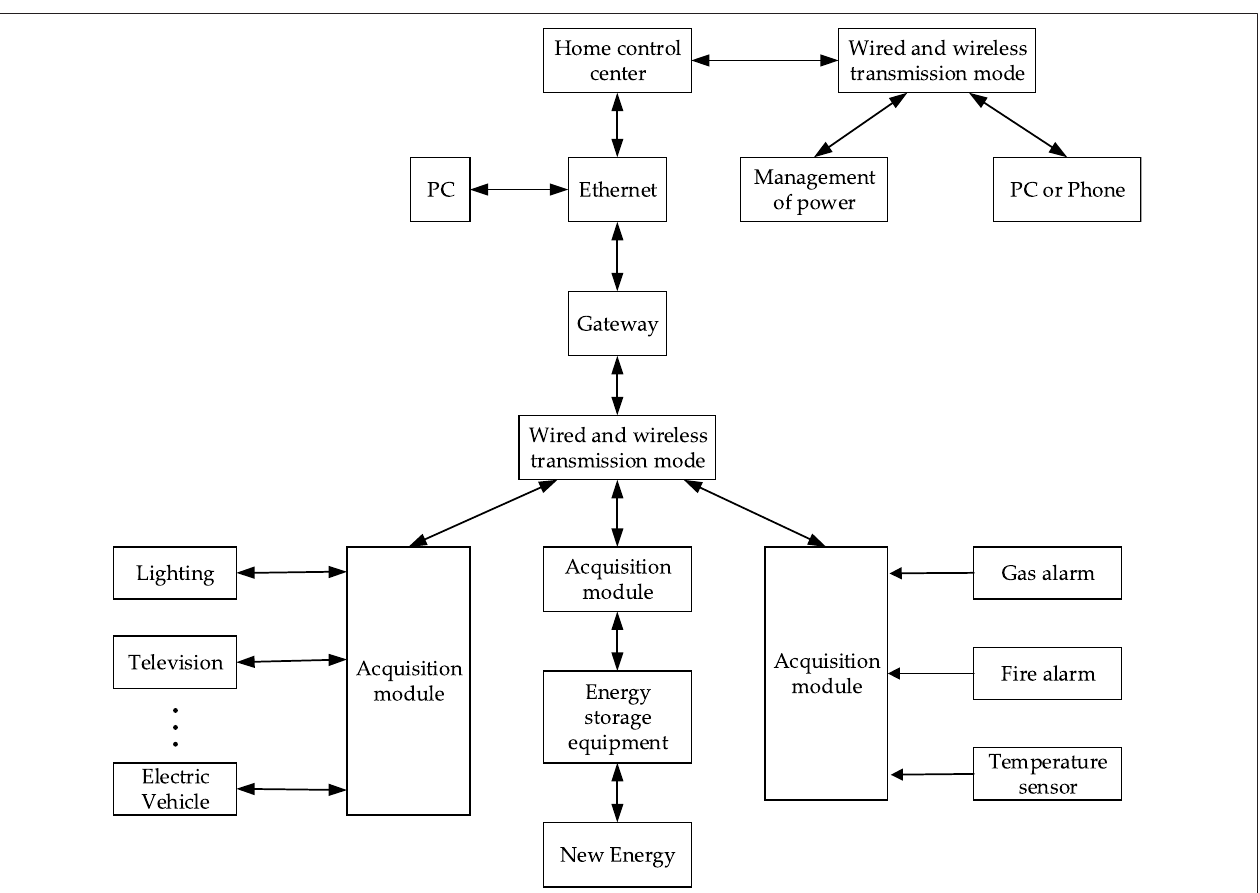
FIGURE 2 | HEMS network structure.